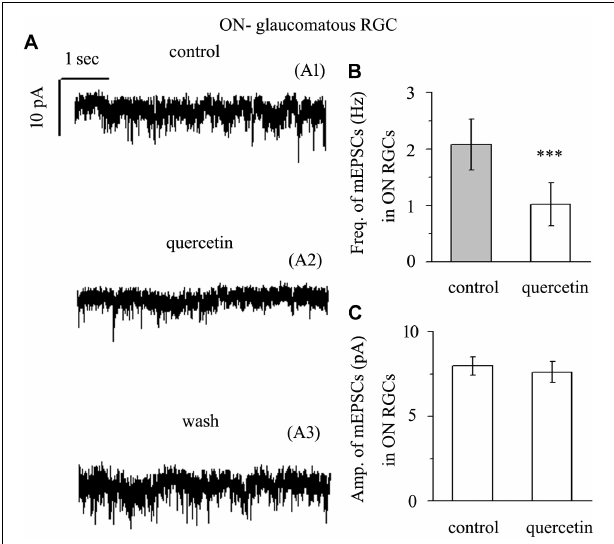
FIGURE 7 | Quercetin significantly inhibited the frequency, but not the amplitude, of mEPSCs in ON-type RGCs. (A) Representative traces showing the effect of 10 µ M quercetin on glutamatergic mEPSCs in ON-type RGCs. (A1) Control conditions; (A2) during quercetin treatment; (A3) recovery. Vertical bar, 10 pA; horizontal bar, 1 s. (B) Summarized data from 10 ON-type RGCs showing that 10 µ M quercetin significantly decreased the average frequency of glutamatergic mEPSCs. (C) Summarized data from 10 ON-type RGCs showing that 10 µ M quercetin did not change the average amplitude of glutamatergic mEPSCs. ∗∗∗ p < 0.001, paired Student’s t